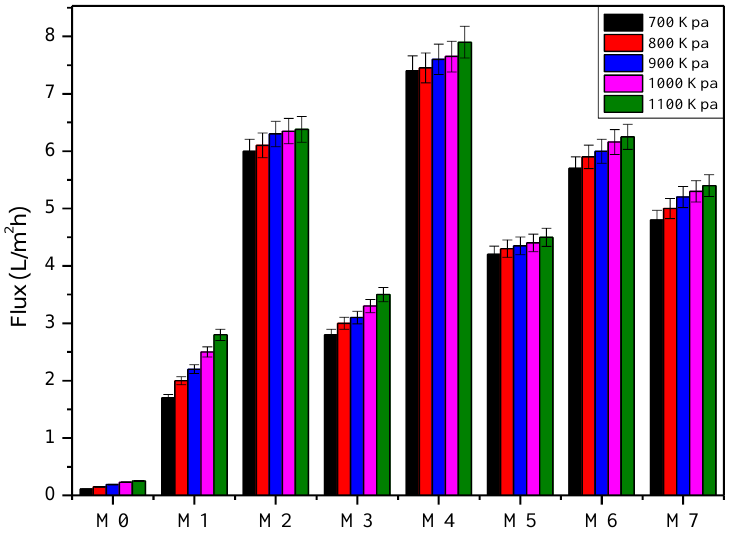
Figure 13. Pure water flux of M0, M1, M2, M3, M4, M5, M6, and M7.